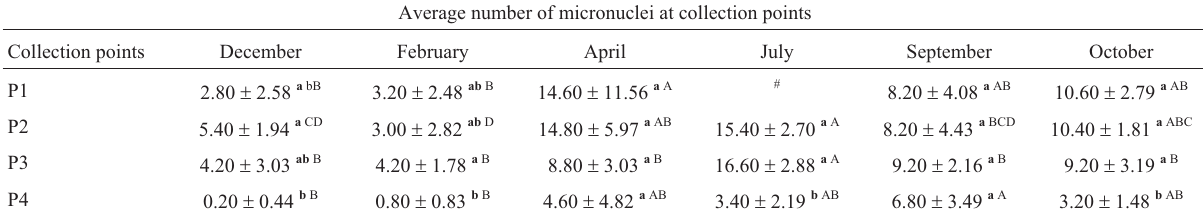
Table 5 - Mean number of micronuclei (MCN) in the erythrocytes of Astyanax altiparanae exposed to water samples collected from P1, P2, and P3 (sur- face water) in the Água Boa stream (Dourados, MS) and P4 (groundwater) during December 2012 and February, April, July, September and October 2013.